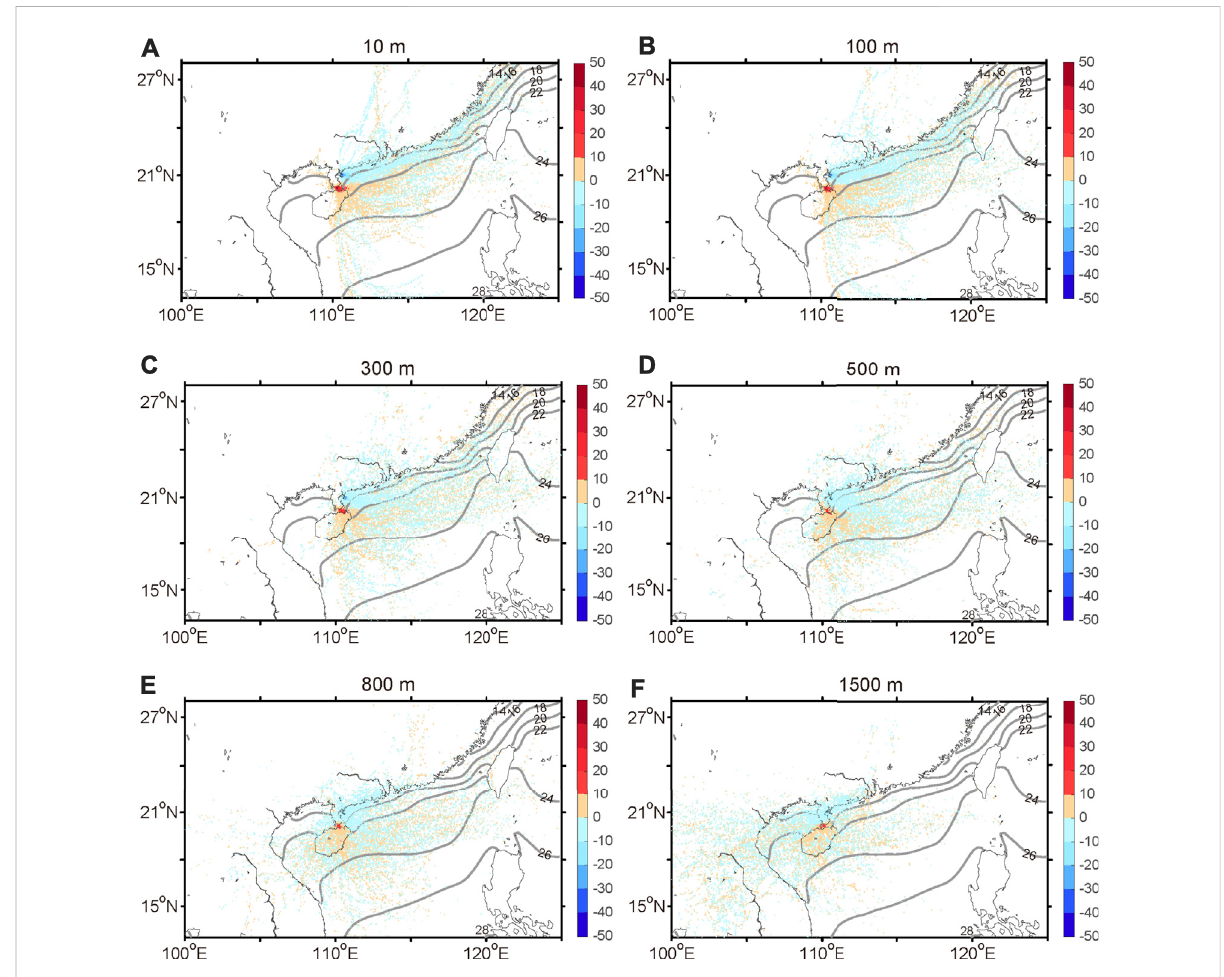
FIGURE 4 Difference in frequency of backward trajectories between Xuwen and Zhanjiang harbors. (A – F) represents 10, 100, 300, 500, 800 and 1500 m of the trajectory above sea level. Contours are the same as in Figure 2.